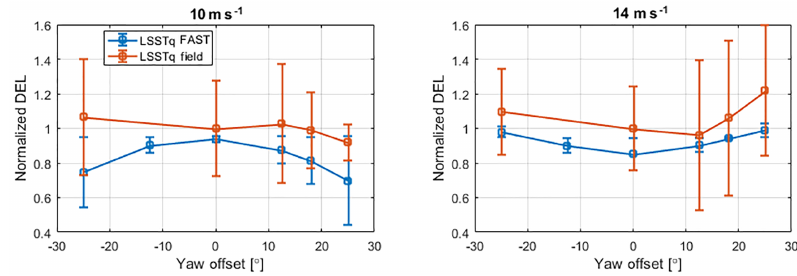
Figure A4. Comparison between predicted (FAST) and measured (field) LSSTq DELs.